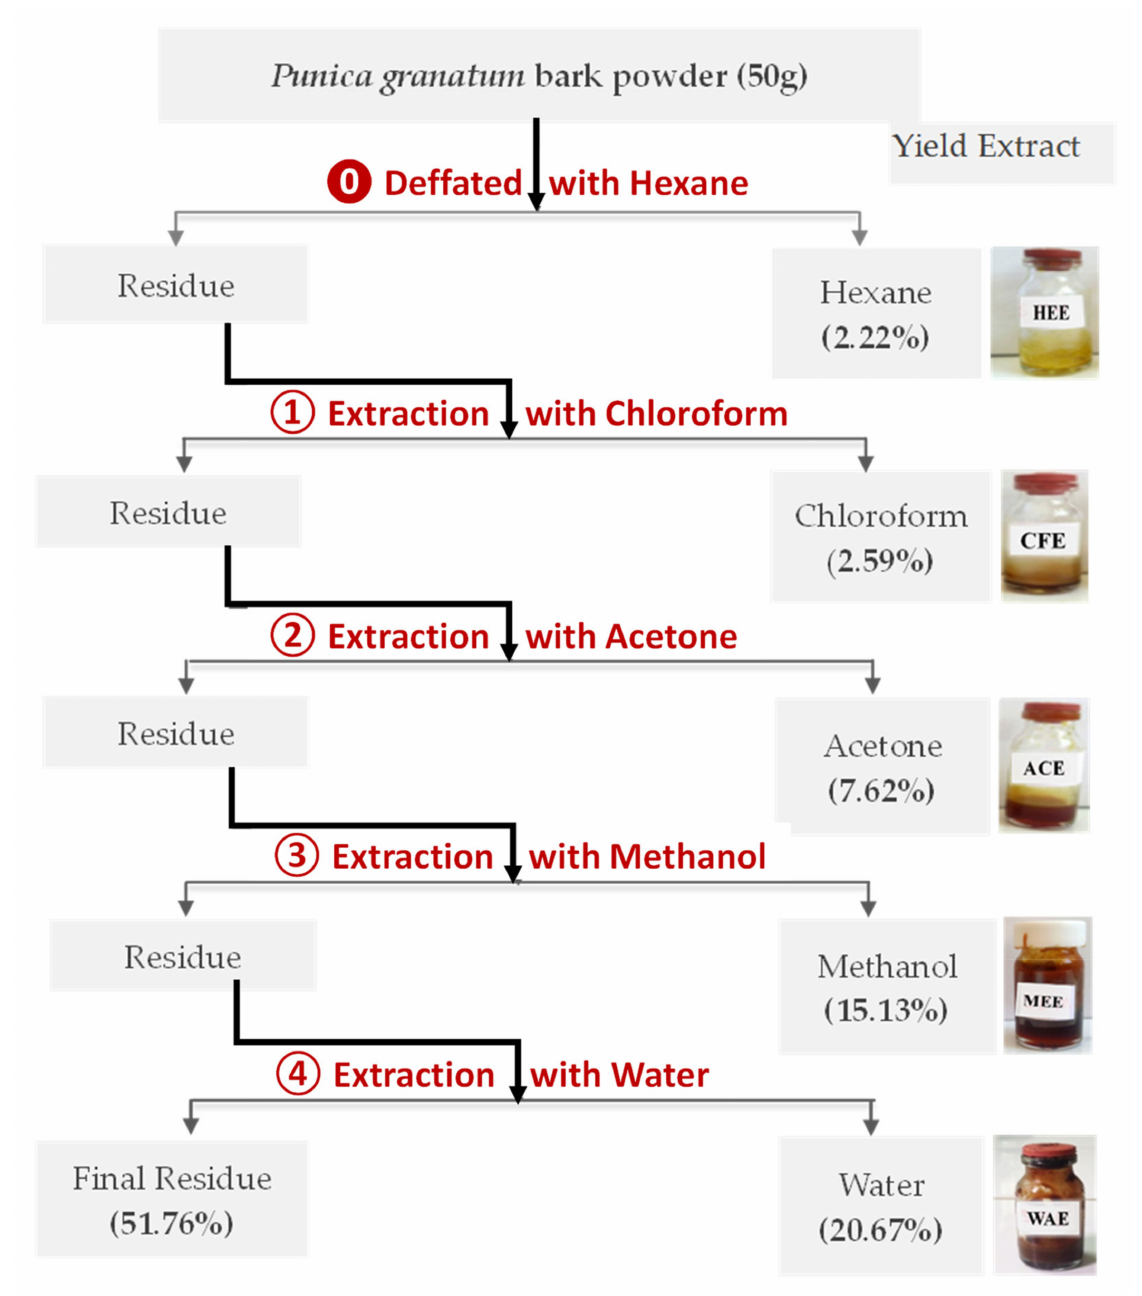
Figure 1. Soxhlet extraction procedure of Punica granatum bark and yield of each extract first defat- ted with hexane (HEE), and then sequentially extracted using solvents with increasing polarities: chloroform (CHE), acetone (ACE), methanol (MEE), and water (WAE). The determination method of the flavonoid content was performed according to the procedure described in the literature by Dalli et al. [22]. To 200 µ L of the sample, 1 mL of distilled water and 50 µ L of sodium nitrate (5% w/v ) were added. After 5 min of evolution at room temperature, 120 µ L of AlCl 3 (10% w/v ) was added and the samples were incubated again for 5 min. Afterwards, 400 µ L of NaOH (1 M) was added and then their absorbances were measured at 430 nm. Quercetin was used as a standard to construct the calibration curve; for this, several standard solutions were prepared beforehand and their absorbances were measured by UV-Visible. The flavonoid content was expressed as the quercetin equivalent (QE, mg per 100 g of dry weight